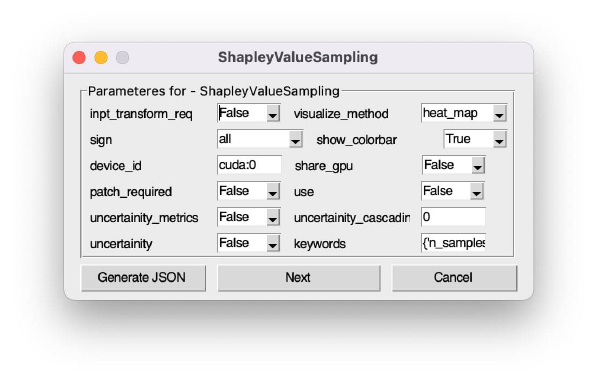
Figure 4. GUI: Method-specific parameter selection for a chosen